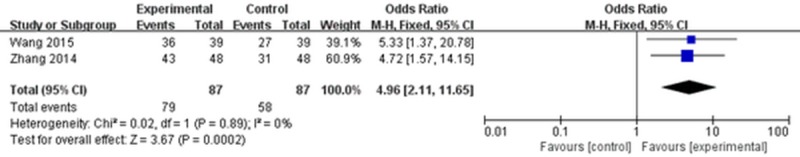
Forest plot of the improvement in stool form (fixed effects model).